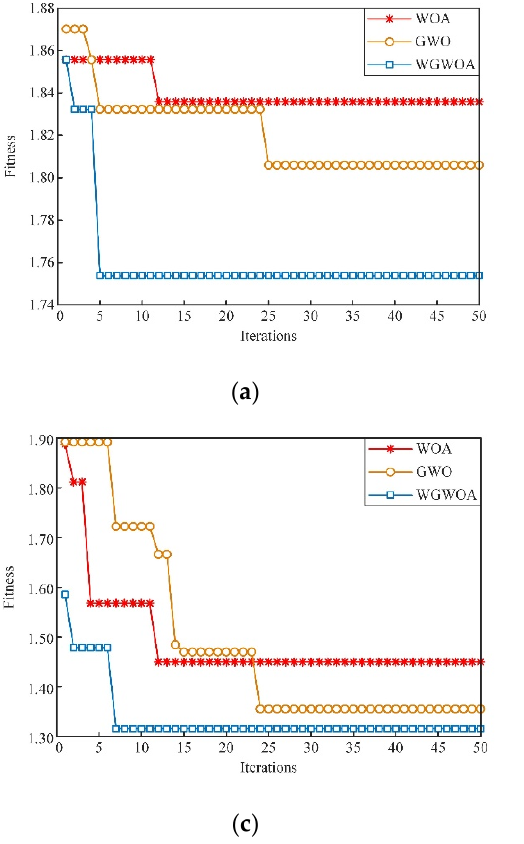
Figure 13. Different algorithms to optimize the fitness curve of VMD, ( a ) normal bearings, ( b ) inner ring cracked bearings, ( c ) outer ring cracked bearings, ( d ) roller cracked bearings.